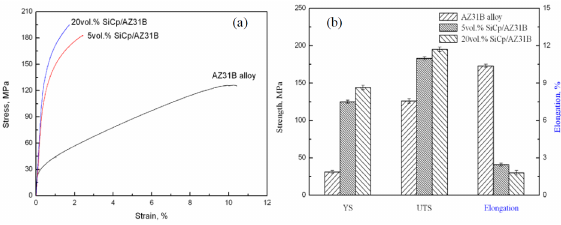
Figure 8: The mechanical properties of as-cast composite and monolithic AZ31B alloy. (a) tensile stain–stress curves, (b) ultimate tensile strength, yield strength and